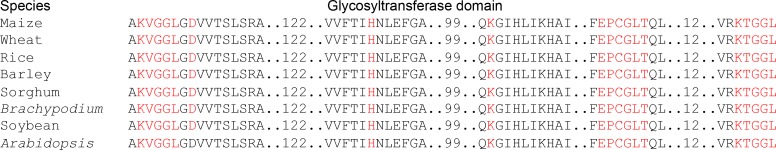
Conserved regions identified in the glycosyltransferase domain of SSIII.Residues involved in ligand binding are depicted in red. Number represents the distance between the conserved regions of domain.